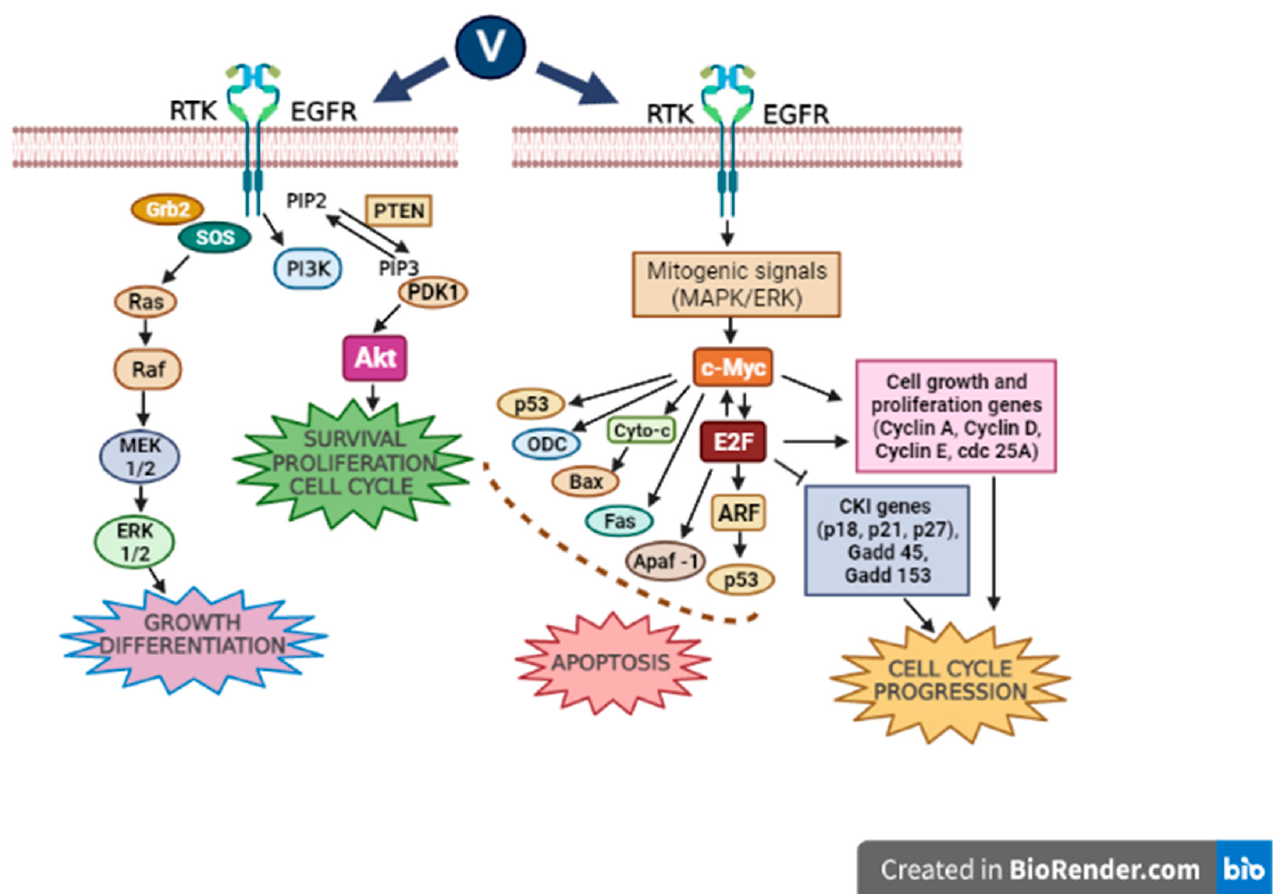
Figure 1. MAPK/ERK cell signaling pathways affected by vanadium compounds. Adapted from [39].